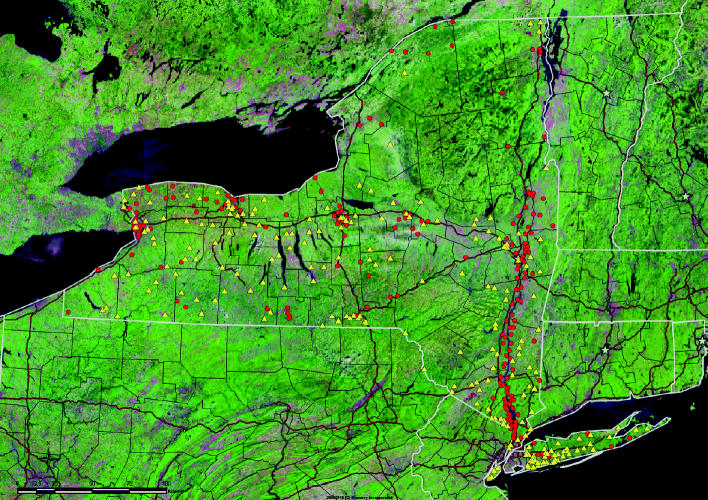
Map of New York State showing the locations of POP sites in red and other-waste sites in yellow. Map prepared by Rick Crowsey, Crowsey Incorporated.